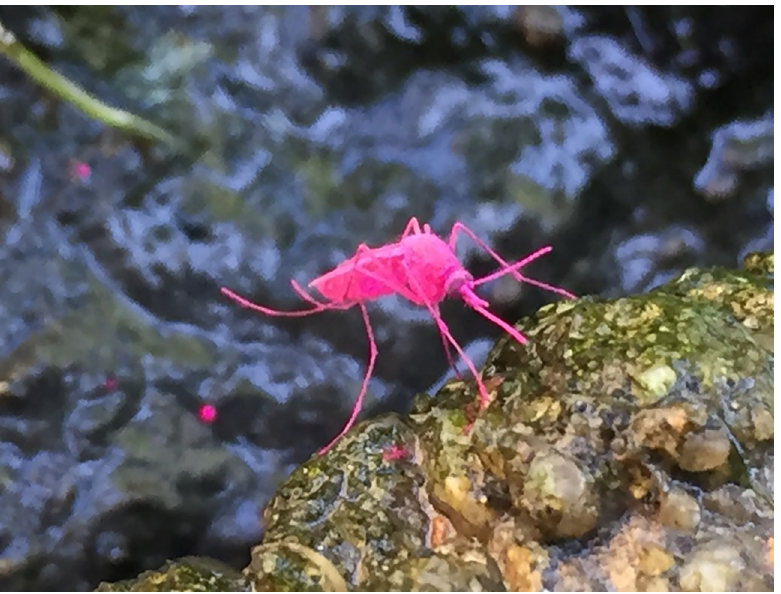
Fig 4. Magenta-marked adult female Culex quinquefasciatus in field conditions Sı´tio Novo, Olinda, RMR, Brazil, July 22–August 21, 2015. [Photo: Anita Ramesh, LSHTM/IAM/FIOCRUZ].